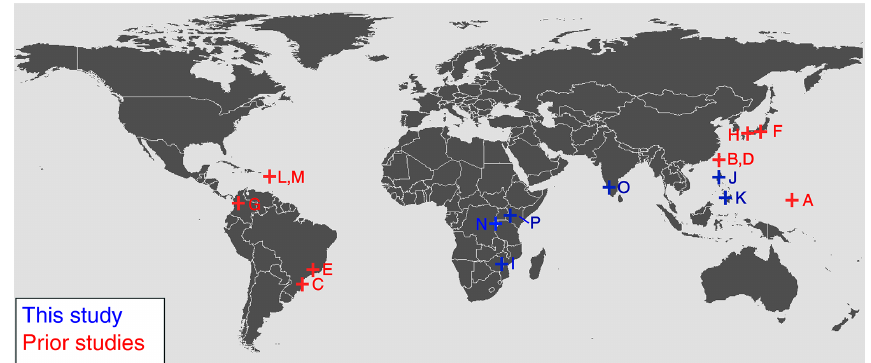
Figure 1. Locations of landslide inventories considered in this study. Locations labeled in red have been published previously, while those in blue are presented for the first time here. Satellite images of the newly mapped landslide inventories can be found in the Supplement. Table 1 contains the details of each of the inventories, organized in alphabetical order.